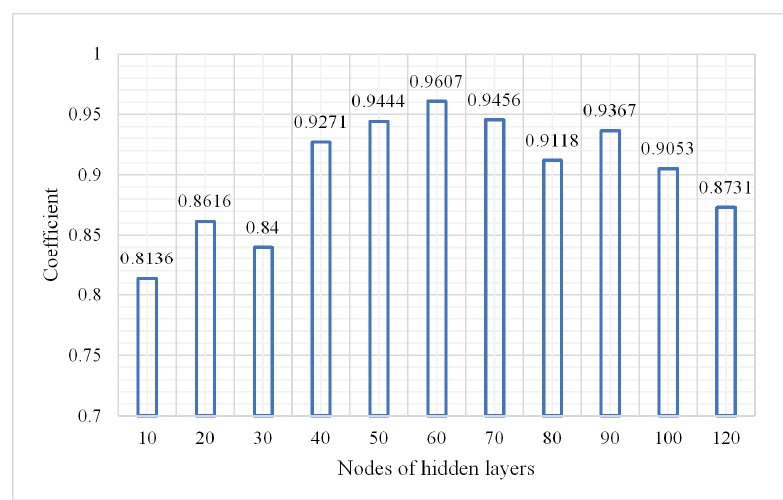
Figure 9. Change in kappa coefficient.